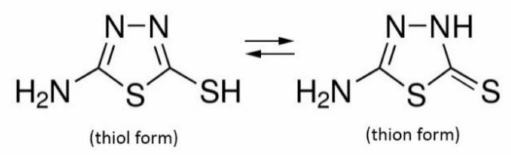
Figure 11. Schematic representation of the thiol and thion forms of ATT.